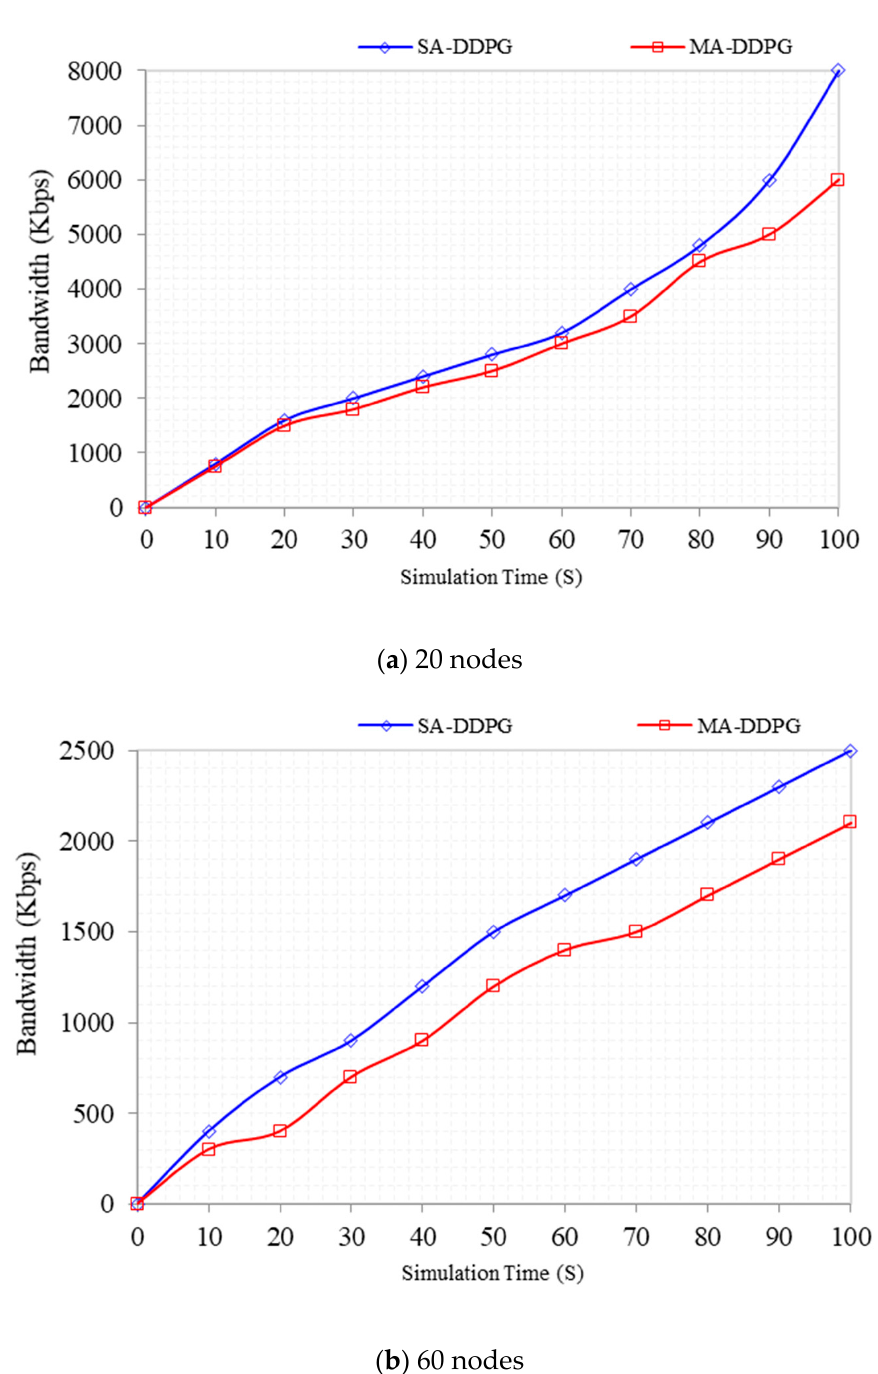
Figure 14. Bandwidth vs. simulation time for SA ‐ DDPG and MA ‐ DDPG.